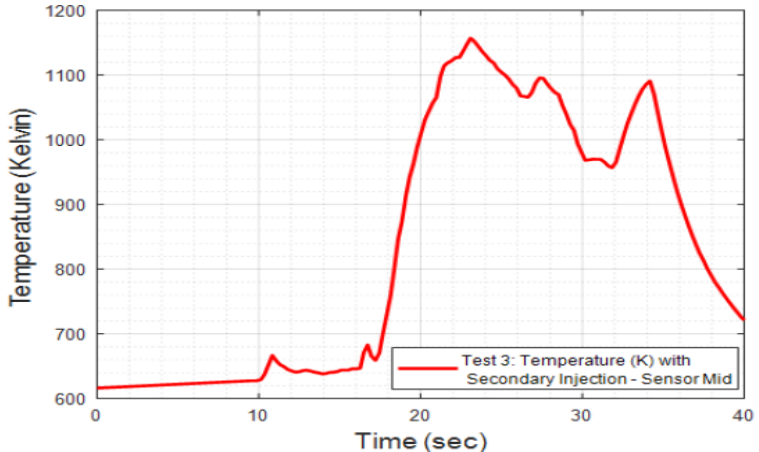
Figure 19. Temperature vs. burn time.